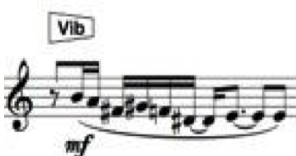
Figure 2 | Excerpt of ...URB to B... musical composition (bar